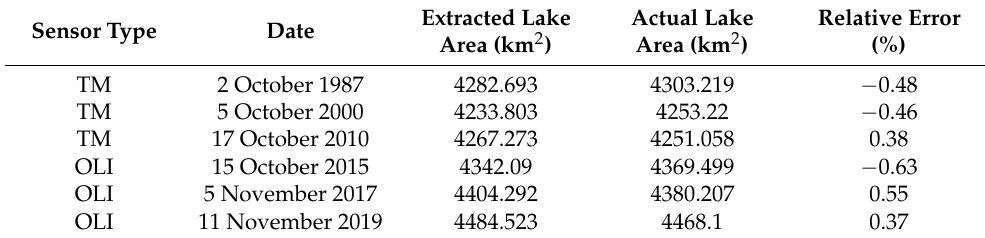
Table 1. Accuracy of extracted lakes based on the RF model.